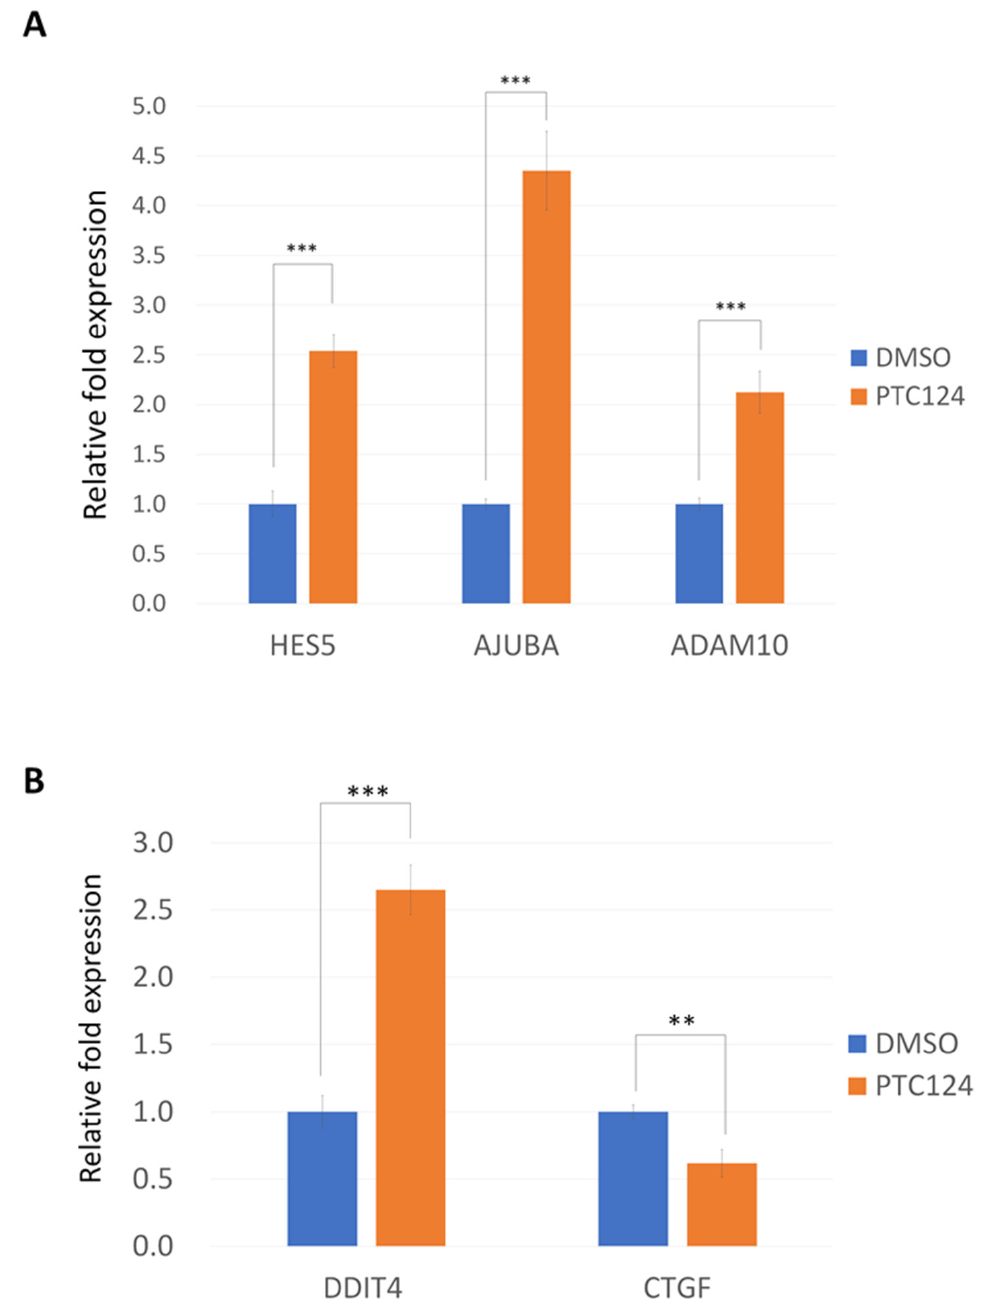
Figure 3. PTC124 can induce NOTCH1 downstream genes and DDIT4 in DOK and HO-1-u-1 cells, respectively. ( A ) PTC124 (50 µM) can induce HES5, AJUBA, and ADAM10 expression in DOK cells (*** p < 0.001). DMSO only was calculated as 1 to normalize for the other conditions. Results are displayed as mean ± SD, n = 3. ( B ) PTC124 (50 µM) can induce DDIT4 and repress CFGF expression in HO-1-u-1 cells (** p < 0.01, *** p < 0.001). DMSO only was calculated as 1 to normalize for the other conditions. Results are displayed as mean ± SD, n = 3.